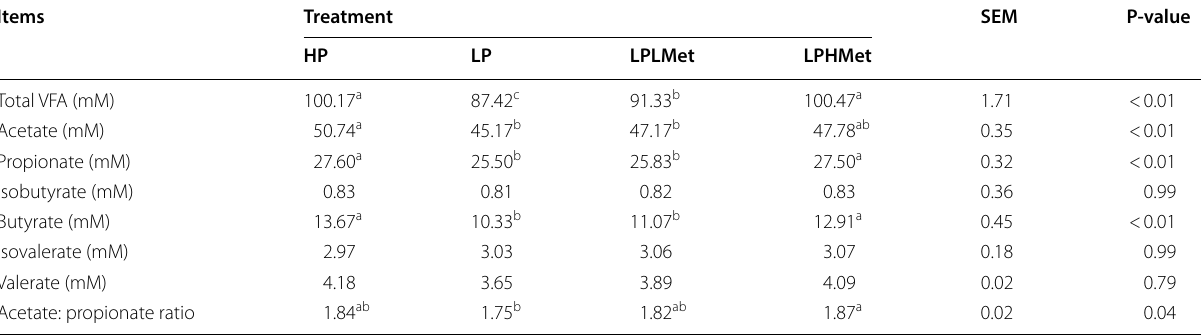
VFA, volatile fatty acids; SEM, standard error of mean a,b,c Superscripts values within the same row, are significantly different at (P <